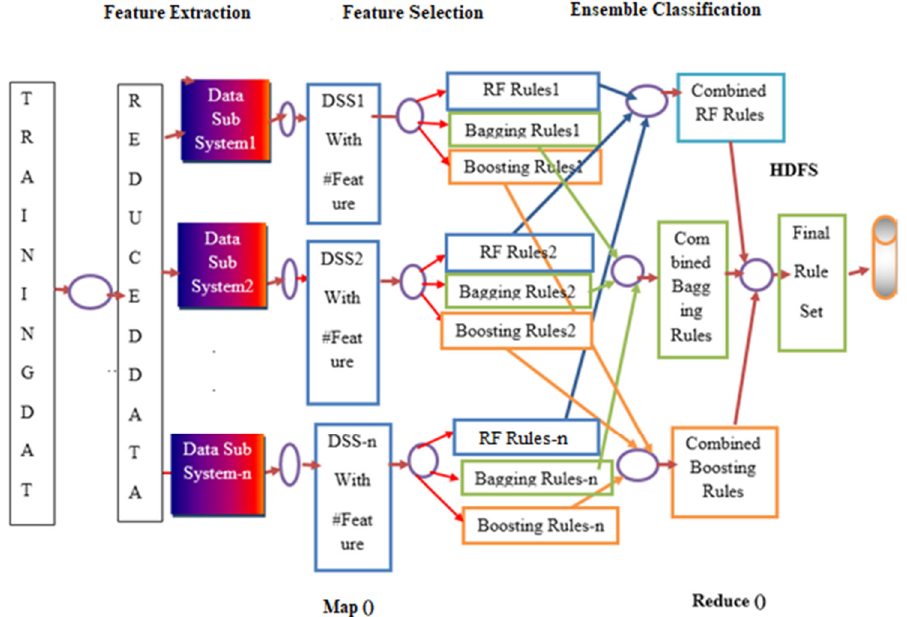
Figure 2. Proposed Big Data ‐ Enabled detailed Disease Prediction Model.